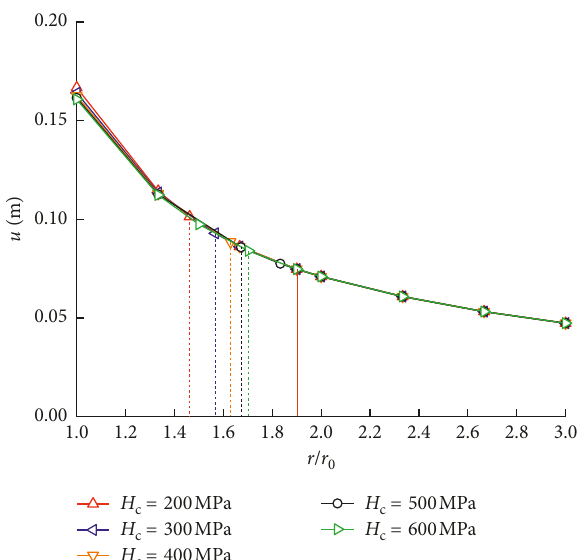
Figure 9: The influence of strain softening on plastic zone radius and displacements.